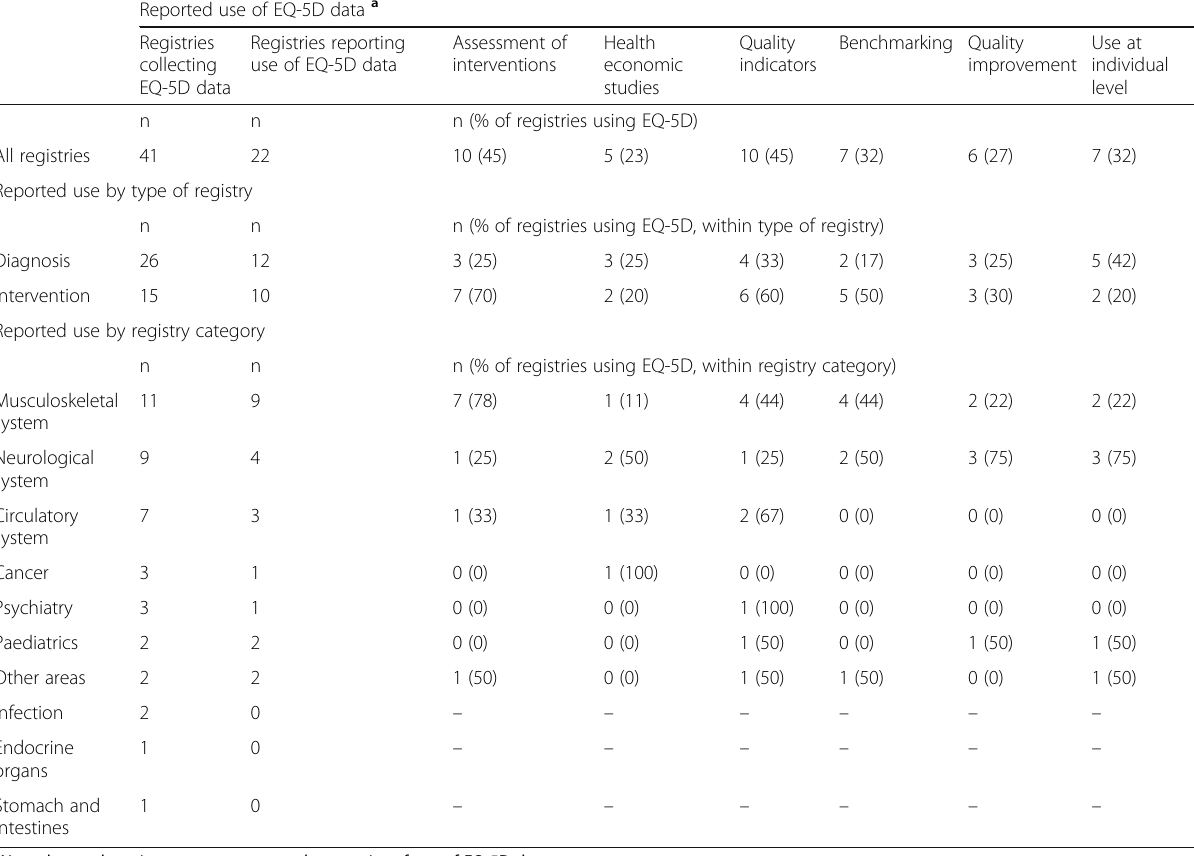
Table 2 Frequency of registries reporting use of EQ-5D data, per category of registry and category of